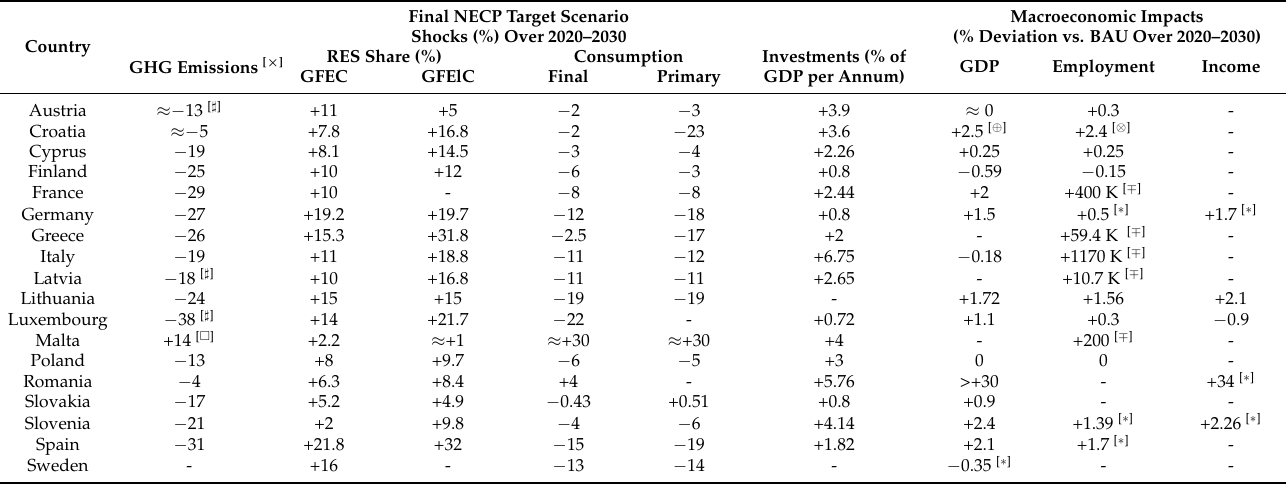
Table 5. Shocks on Member States’ general economies triggered by implementing the measures foreseen under the final NECPs, and the key macroeconomic impacts arisen by simulating these shocks over the 2020–2030 period [3].